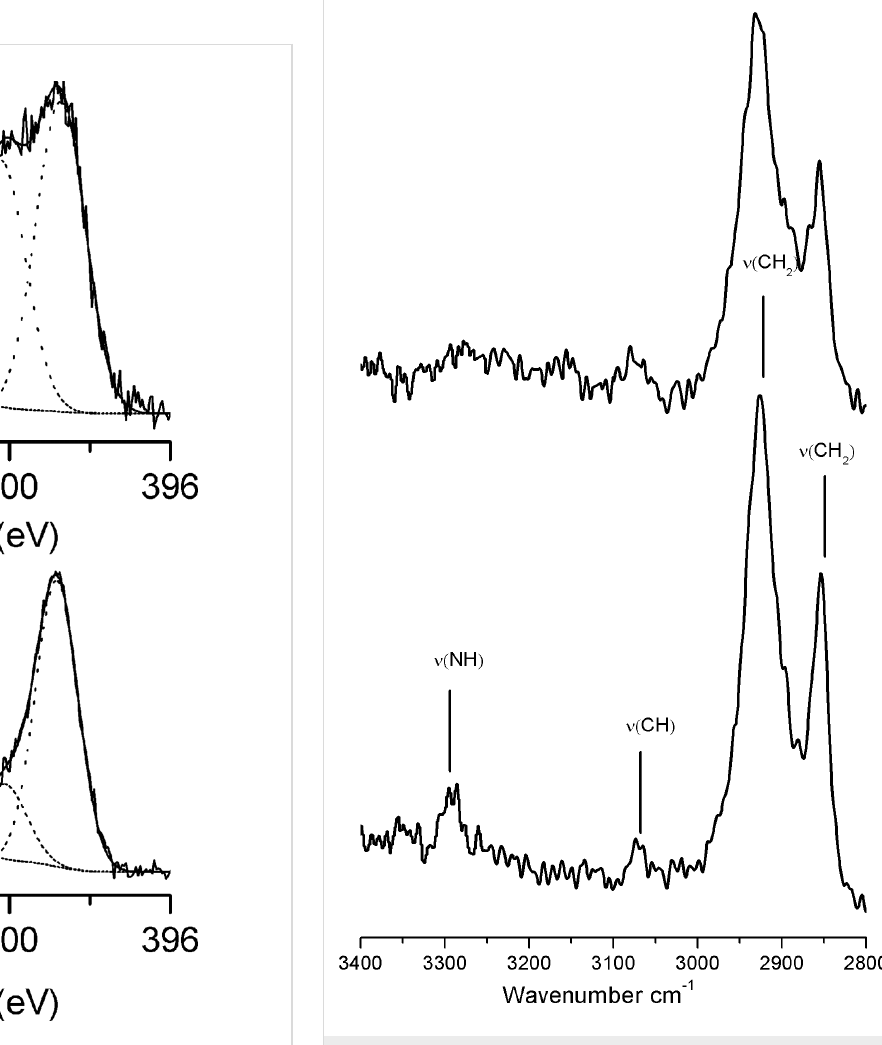
Figure 6: FTIR spectral region between 3400–2800 cm − 1 (CH x stretching region) of PSi-1-Pc (below) and PSi-Co-Pc